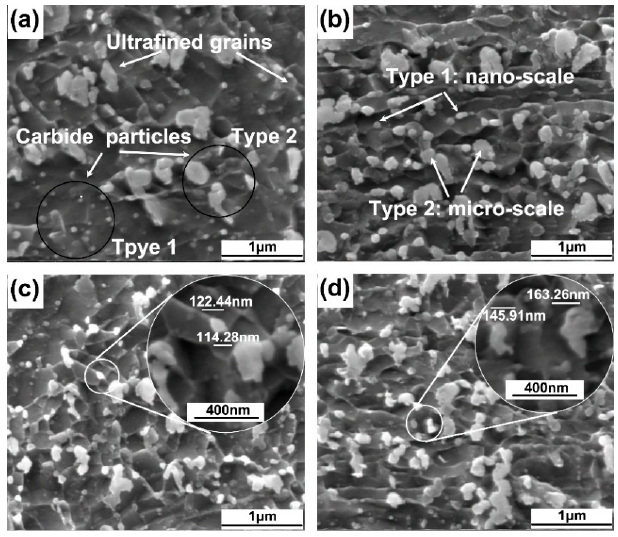
Figure 7. Recrystallization ferrite and carbide particles at different reduction amounts ( a ) 50%; ( b ) 60%; ( c ) 70%; and, ( d ) 80%.